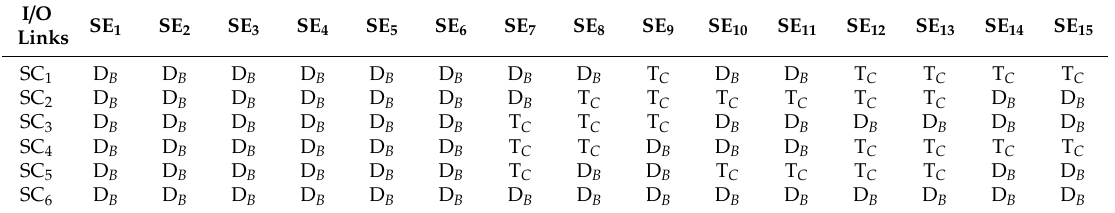
Table 3. Switching combinations of OSEs for a particular I / O link in the 6-port HCROS.